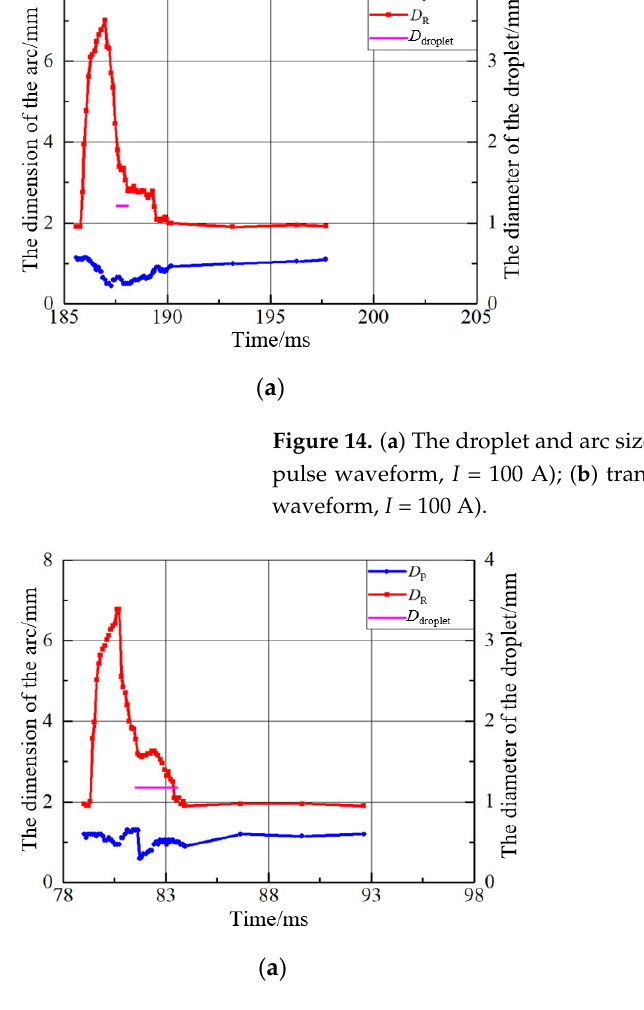
Figure 15. ( a ) The droplet and arc size at different times during a single pulse period (trapezoid pulse waveform, I = 100 A); ( b ) transient arc pressure and heat input power (trapezoid pulse waveform, I = 100 A).